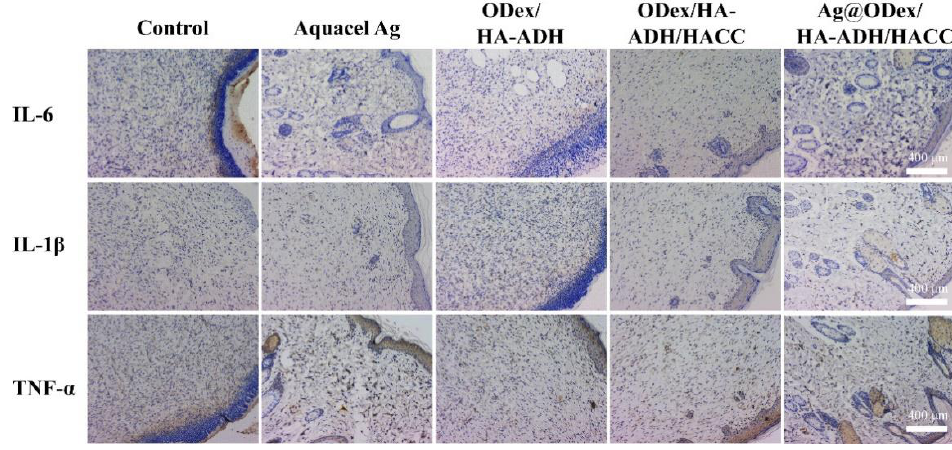
Figure 7. Immunohistochemical staining of IL-6, IL-1 β and TNF- α of wound section on day 14, scale bar: 400 μm.